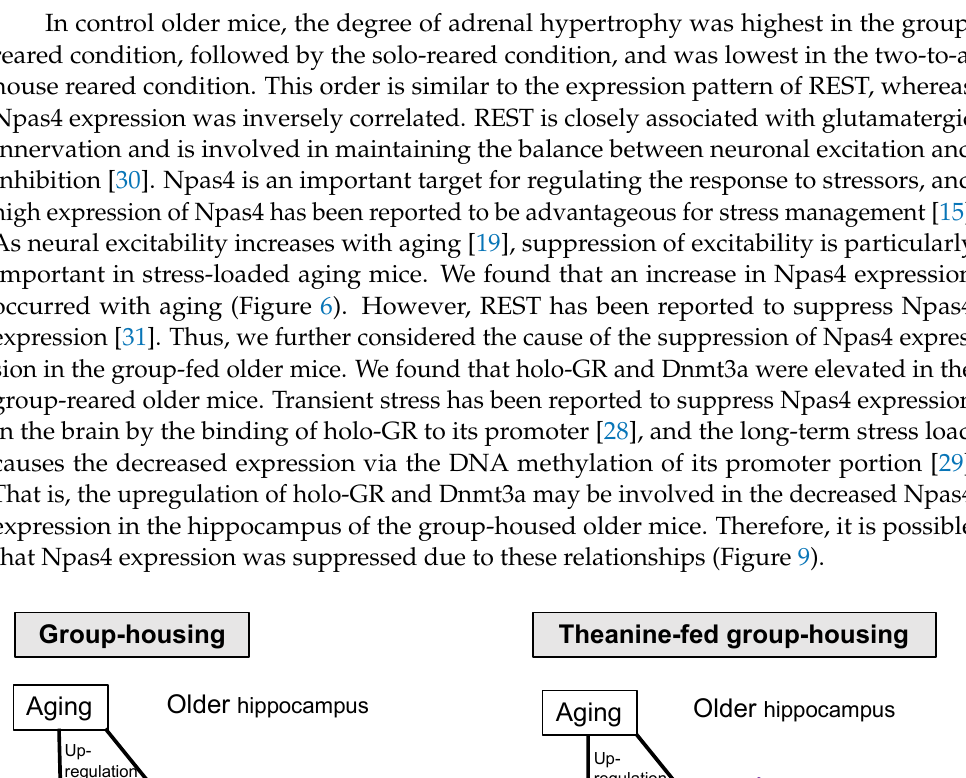
Table 3. Experimental groups.